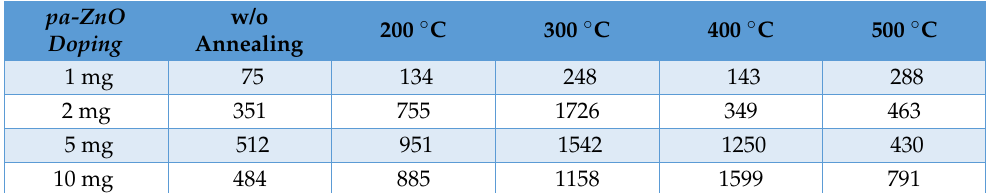
Table 1. Sensitivity of pa-ZnO-doped CsPbBr 3 perovskite acetone sensors with treatment of annealing at various temperatures and pa-ZnO doping amounts at 4.9 V.